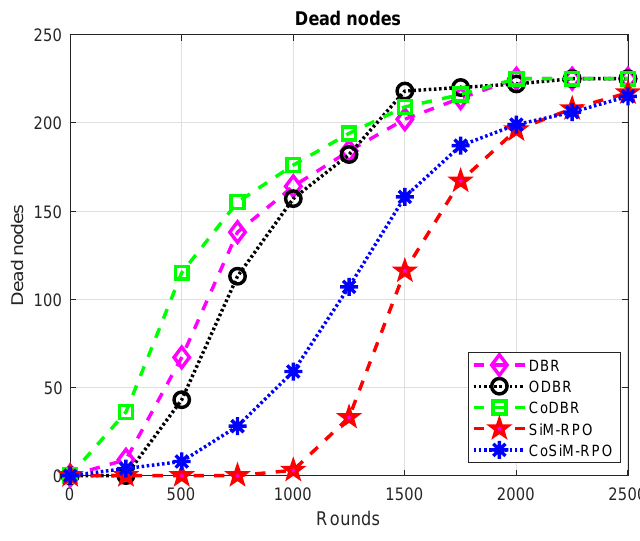
Figure 11. Number of dead nodes.